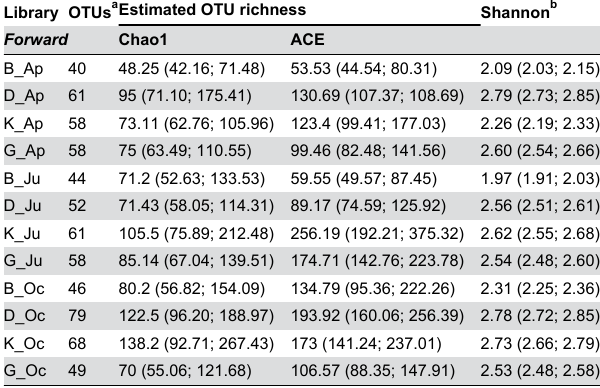
Table 2. Richness estimates and diversity indices for forward amplicon libraries at 90% similarity cutoff after random resampling of sequences to the same depth (1921 sequences).